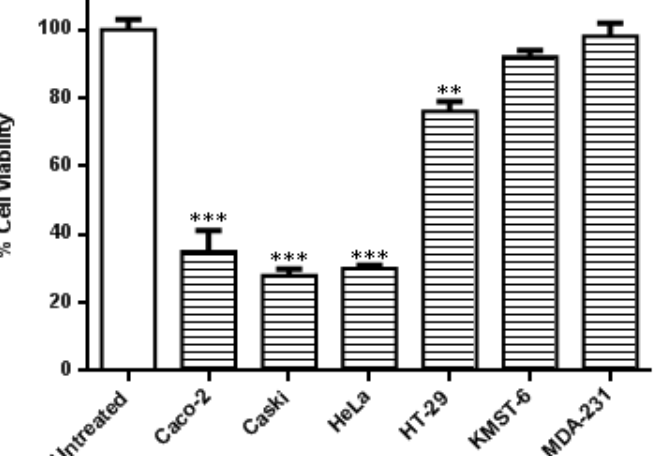
Figure 2. Effects of the co-treatment on the viability of different cell lines. Cells were treated with HB-AuNPs-DOX (1000 µg/mL HB-AuNPs and 1.56 µg/mL DOX) for 24 h, and the viability of the cells was assessed using an MTT assay. Results are expressed as mean ± standard error of the mean (SEM). Data were considered statistically significant if p < 0.05, *** p < 0.001, ** p < 0.01.